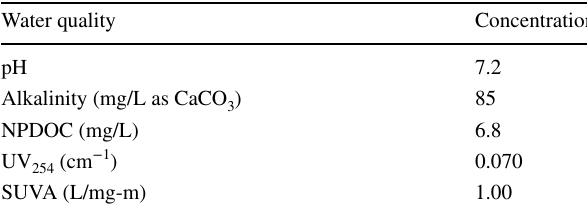
Table 1 Characteristics of source water prior to coagulation Water quality